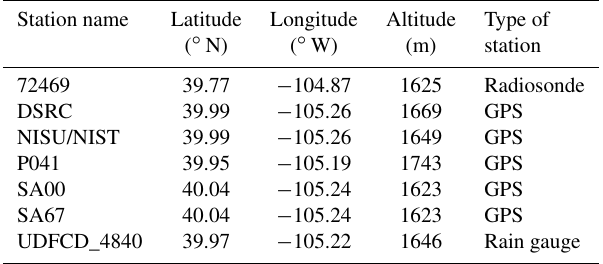
Table 2. The geographic and topographic information of the pri- mary GPS, rain gauge, and radiosonde stations used in this study.